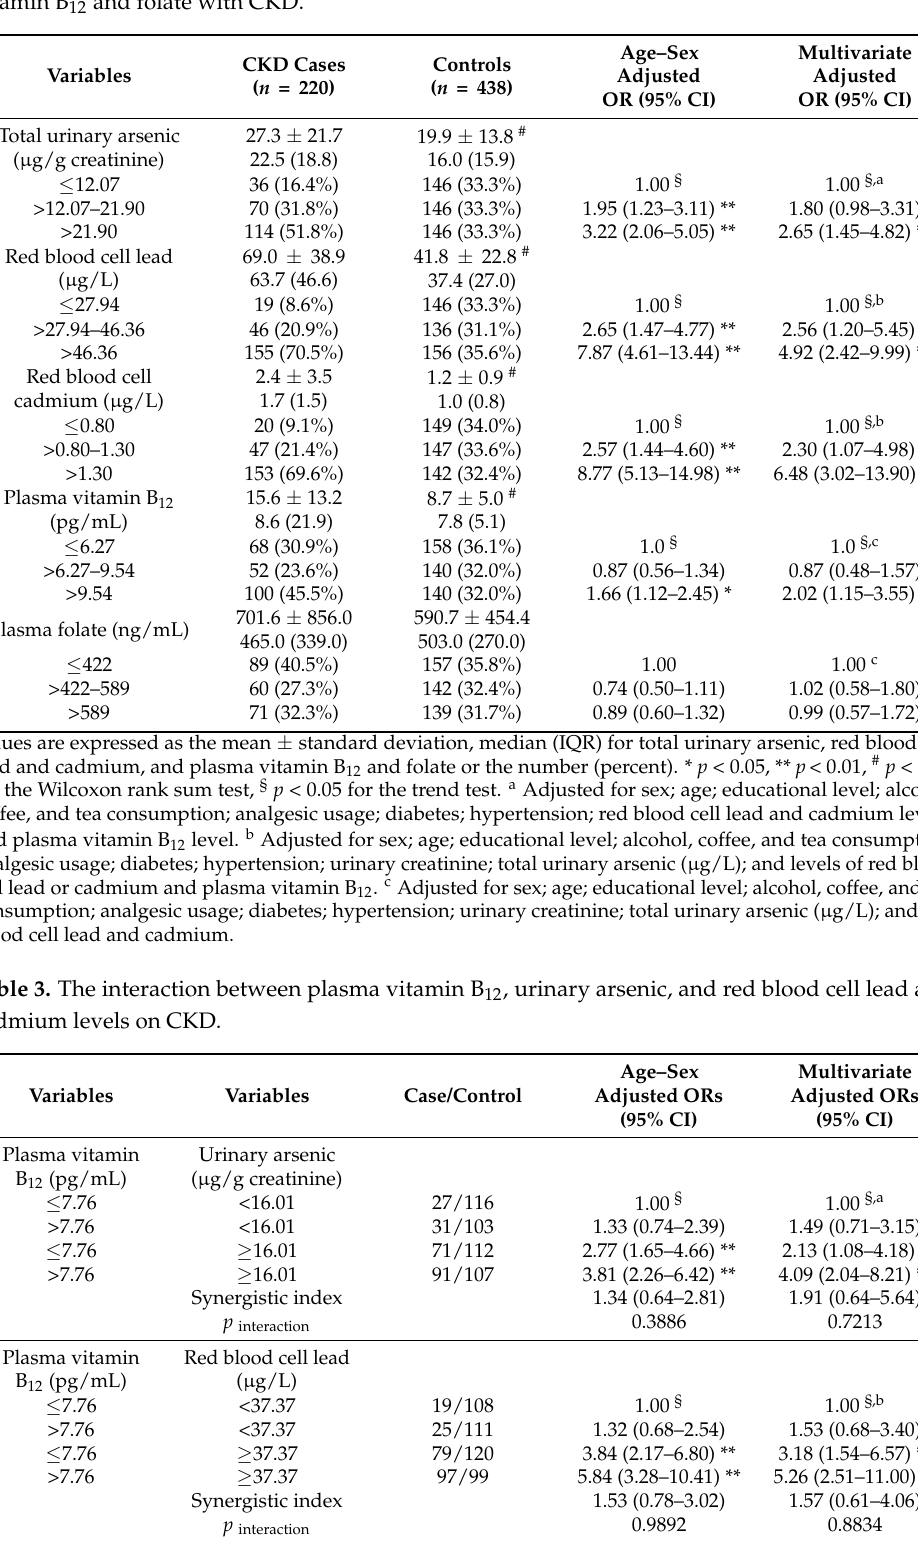
Table 2. Association of the levels of total urinary arsenic, blood cadmium and lead, and plasma vitamin B 12 and folate with CKD.